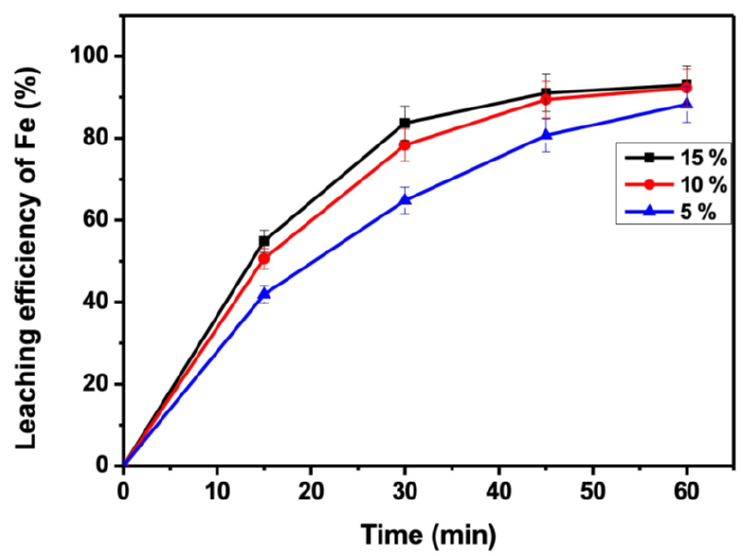
Figure 7. The influence of solid–liquid ratio on Fe dissolution from ilmenite. Conditions: particle size, +150 µ m; acid concentration, 7.5 M; solid–liquid ratio, 1:10, 1:20, and 3:20; agitation speed, 450 rpm; temperature, 90 ◦ C; agitation time, 60